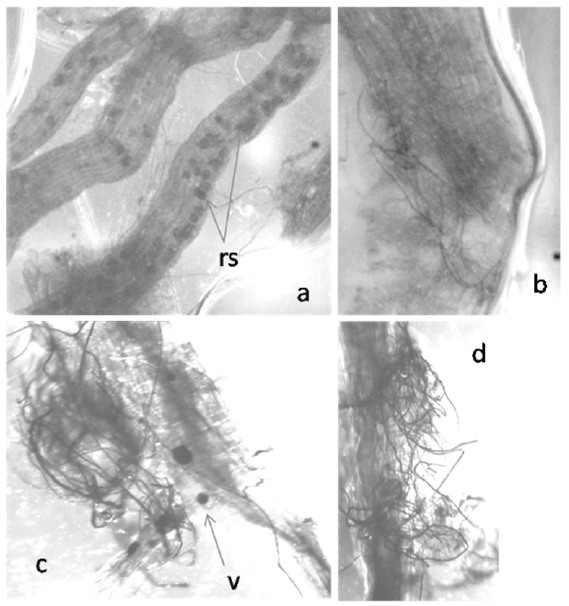
Figure 2. Tomato roots infected with arbuscular mycorrhizal fungi, cleared and stained with KOH- lactophenol blue treatment. ( a ) Roots invaded by resting spores (rs) × 50; ( b ) intra-radical hyphae × 50; ( c ) AMF-infected area with a visible vesicle (v) × 100; ( d ) an extensively AMF-infected area × 100. Numbers of AMF-infected areas per root weight, detected at 28 dpt, revealed a diffused infection in plants treated with Myco1 and Myco2, with respect to Myco3; untreated plants showed negligible infection (Figure